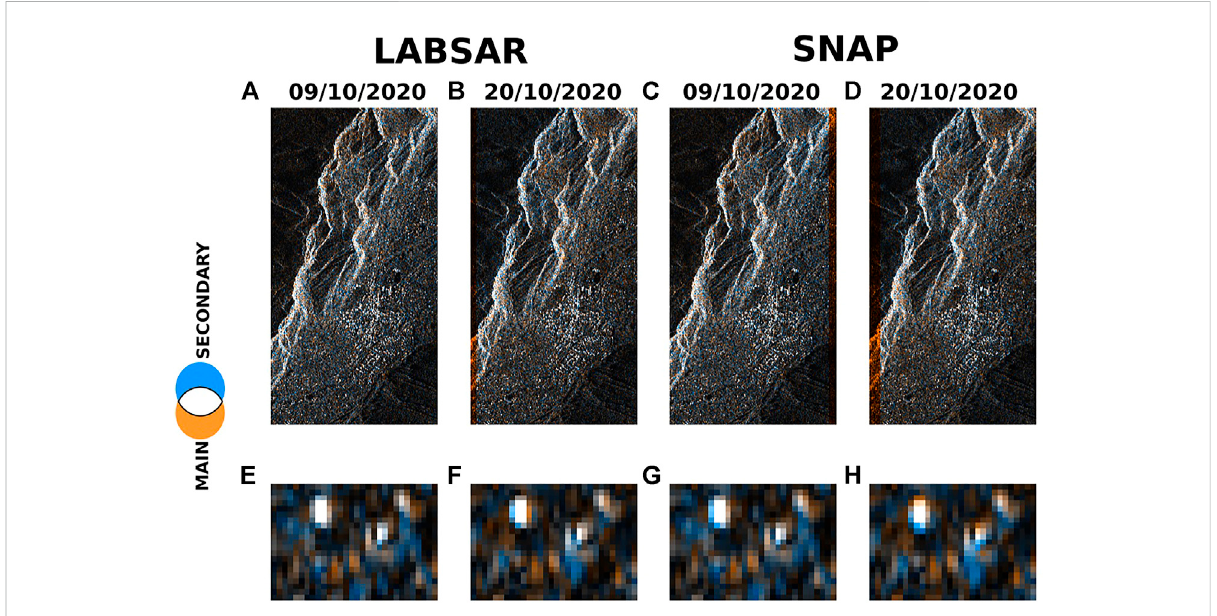
FIGURE 4 Intensity of the coregistered secondary image on the main image. Orange: the main image and blue: the secondary image (A,E) LabSAR: the secondary 09/10/2020 vs. the main 28/09/2020 image, (B,F) LabSAR: the secondary 20/10/2020 vs. the main 28/09/2020 image, (C,G) SNAP: the secondary 09/10/2020 vs. the main 28/09/2020 image, (D,H) SNAP: the secondary 20/10/2020 vs. the main 28/09/2020 image. (A – D) Full image (E – H) zoom on three point-like scatterers in the city of